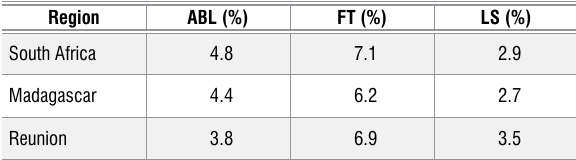
Percentage variability recorded in the atmosphere boundary layer (ABL), free troposphere (FT) and lower stratosphere (LS) over the three selected areas